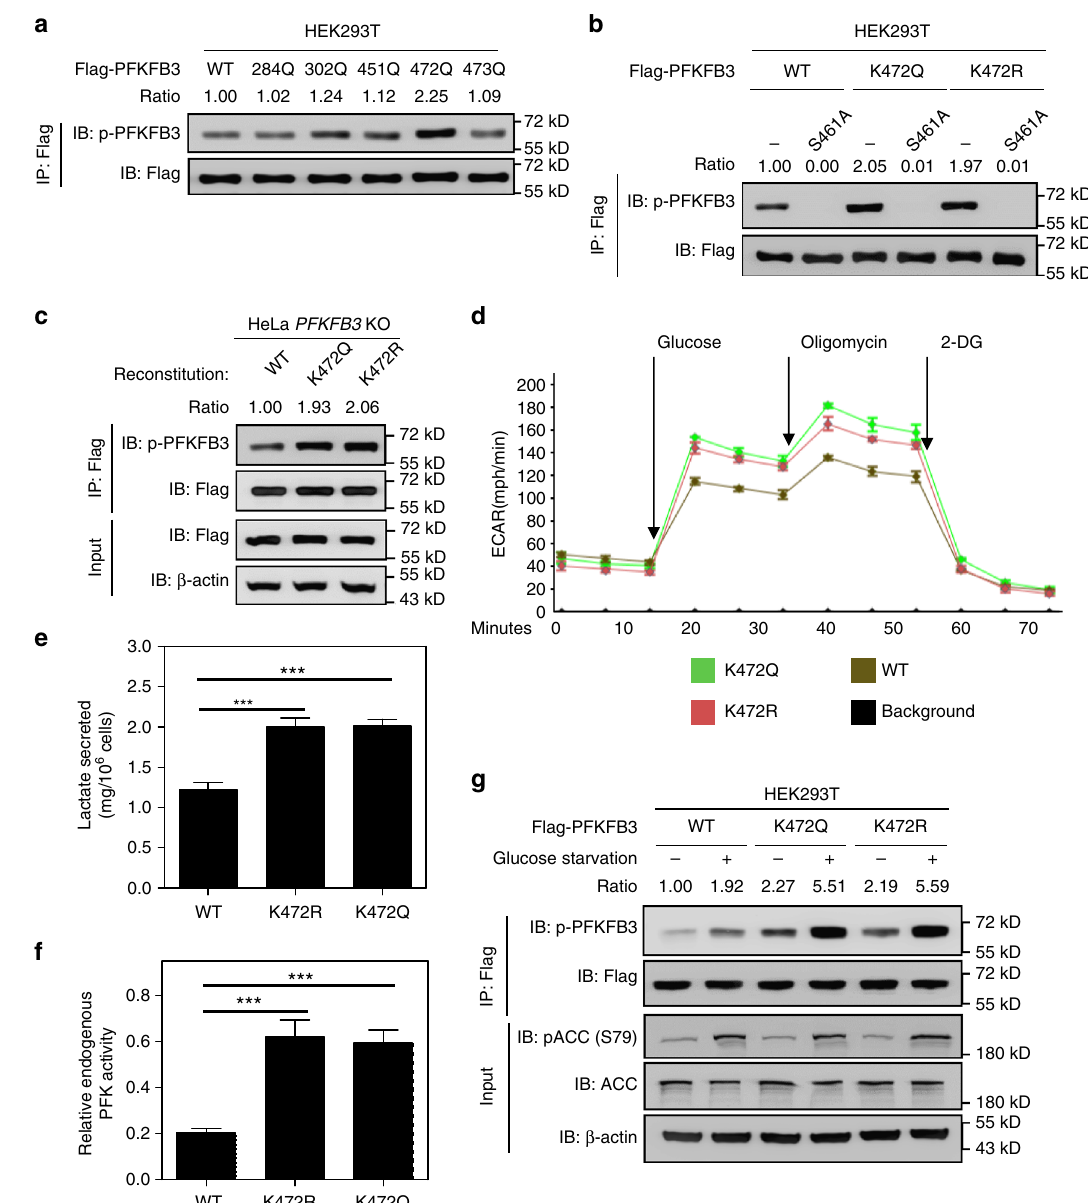
Fig. 4 Cytoplasmic PFKFB3 potentiates S461 phosphorylation. a K472Q mutant of PFKFB3 shows higher phosphorylation by AMPK. Flag-tagged WT PFKFB3 or mutants were transiently expressed in HEK293T cells. PFKFB3 was immunoprecipitated with Flag beads, followed by immunoblotting with the antibody recognizing phospho-AMPK substrate motif. Relative PFKFB3 phosphorylation was normalized by Flag protein. b K472Q or K472R mutation enhances PFKFB3 phosphorylation by AMPK, which is blocked by S461A mutation. Flag-tagged WT PFKFB3 or its mutants were transiently expressed in HEK293T cells. Phosphorylation of Flag-tagged proteins was examined as in a . c Establishment of PFKFB3 KO HeLa cells that stably express Flag-tagged WT, K472Q or K472R mutant of PFKFB3. d HeLa cells expressing K472 mutants exhibit increased glycolysis (ECAR rate) compared to those expressing WT PFKFB3. HeLa stable cells described in c were subjected to ECAR assay. Data are shown as mean with s.d. of three biological replicates. e HeLa cells expressing K472 mutants exhibit increased lactate secretion compared to those expressing WT PFKFB3. Lactate in the culture medium of PFKFB3 KO HeLa cells that stably express Flag-tagged WT, K472Q or K472R mutant of PFKFB3 were measured. Data are presented as mean ± s.d. of three biological replicates, and statistical analyses were performed using one-way ANOVA with Dunnett ’ s post-test. *** P < 0.001 for the indicated comparison; n.s., not